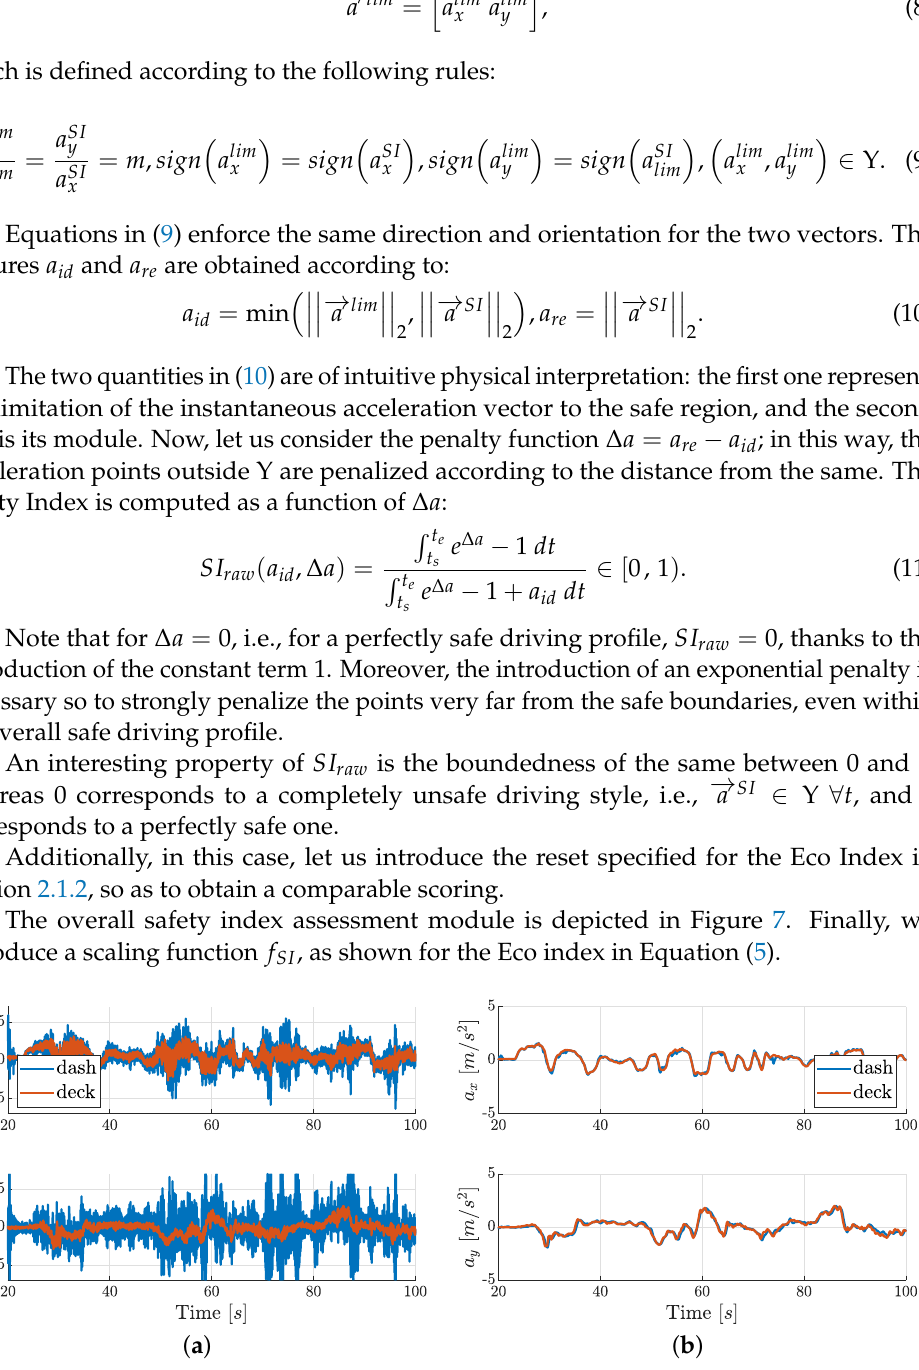
Figure 5. Longitudinal and lateral accelerations: raw pre-processed signals (left plot) and driver- oriented filtering (right plot). ( a ) Raw signals. ( b ) Filtered